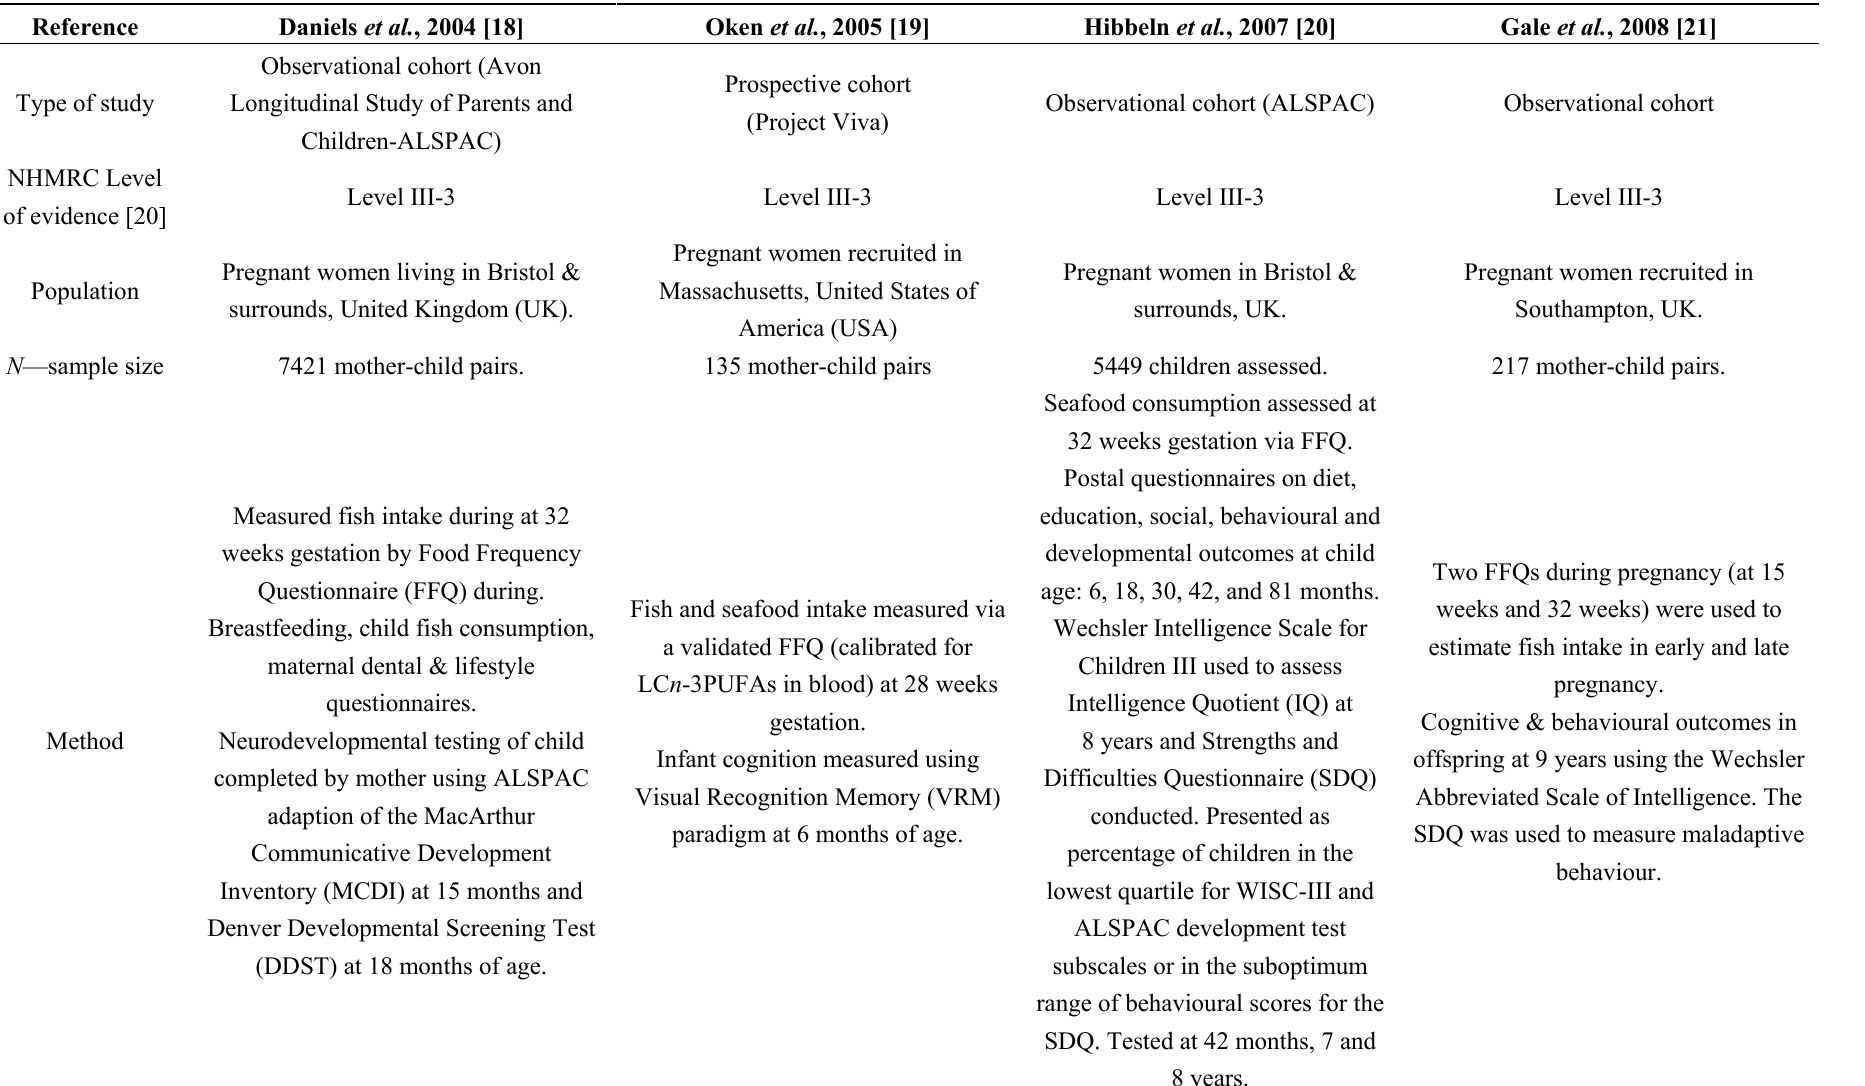
Table 2. Summary and quality rating for reviewed